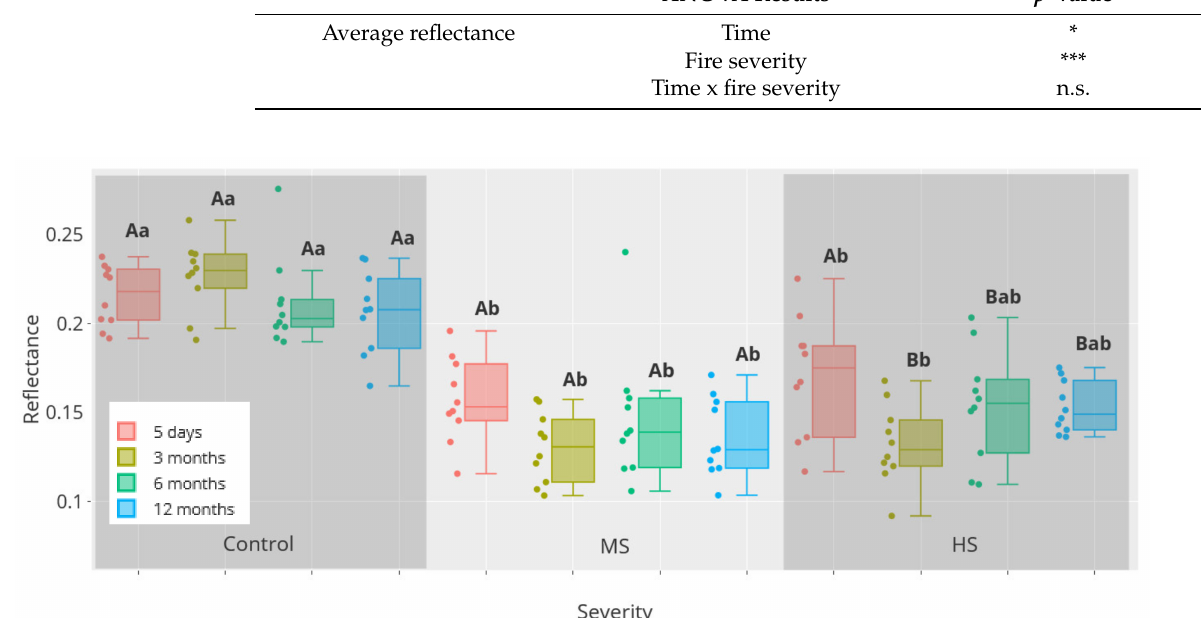
Figure 2. Two-way ANOVA results for soil reflectance. Box plot of soil reflectance from four sampling dates grouped by fire severity. Hanging bars (upper and lower fence), upper box line (quartile 3), line inside the box (median), and lower box line (quartile 1). Different letters represent significant ( p < 0.05) differences between sampling periods (upper-case letters) and fire severity (lower-case letters). Abbreviations: moderate fire severity (MS); high fire severity